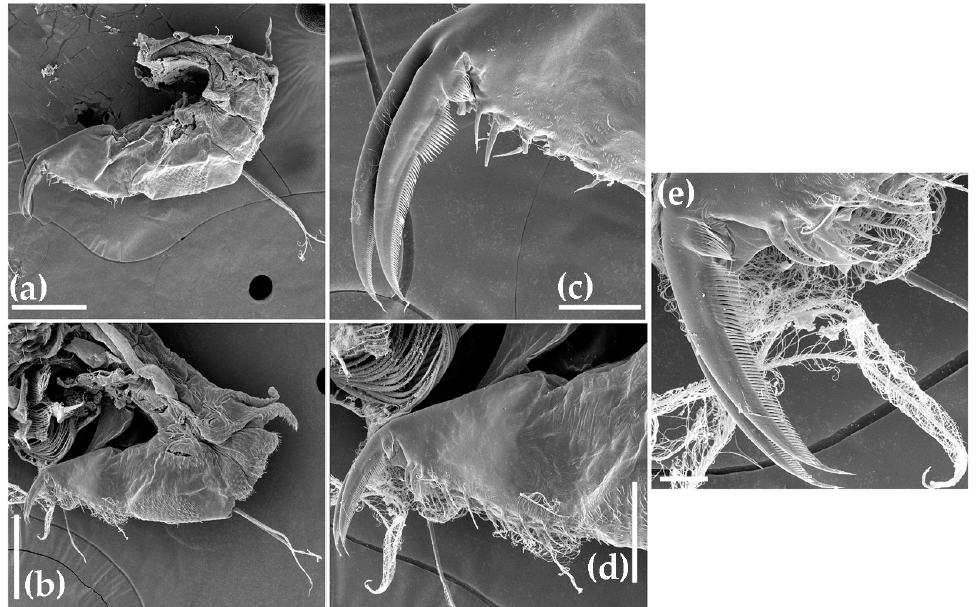
Figure 3. Daphnia arabica sp. nov., a parthenogenetic female from Al Shuwaib Dam, near Al Ain city, United Arab Emirates. ( a , b ) Postabdomen. ( c – e ) Postabdominal claws. Scale bars are 0.2 mm for ( a , b ); 0.1 mm for ( d ), 0.02 mm for ( c , e ).